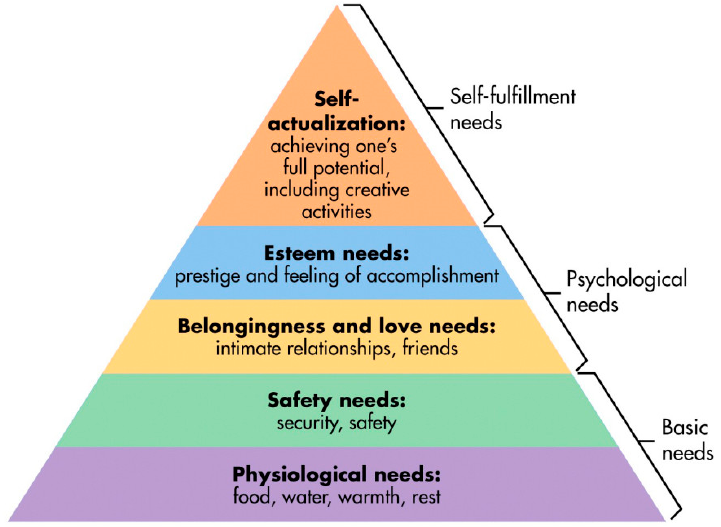
Figure 6. Maslow’s hierarchy of needs (source: McLeod [65]).